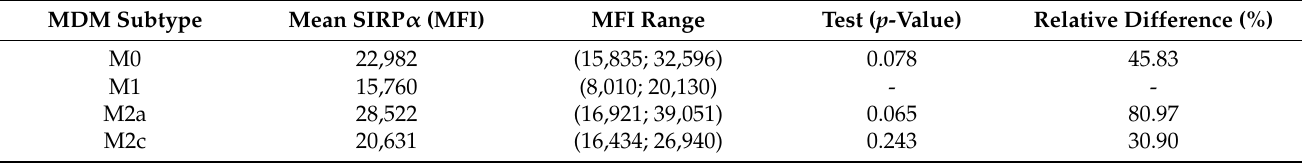
Table 1. SIRP α flowcytometry.